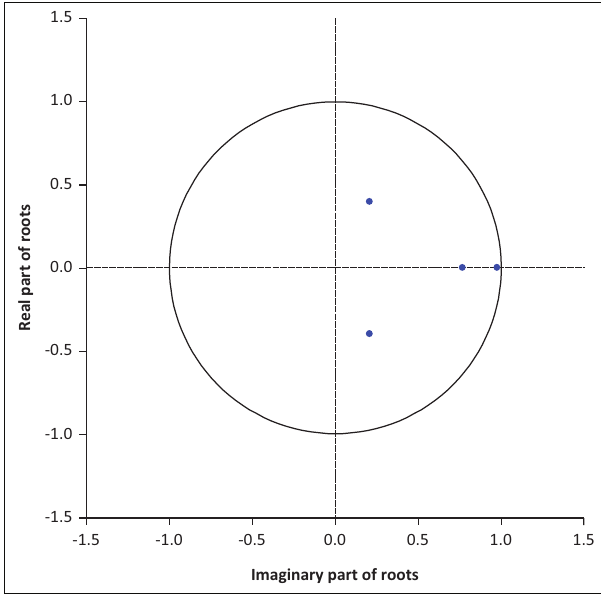
FIGURE 3: Inverse root of autoregressive characteristic polynomial.